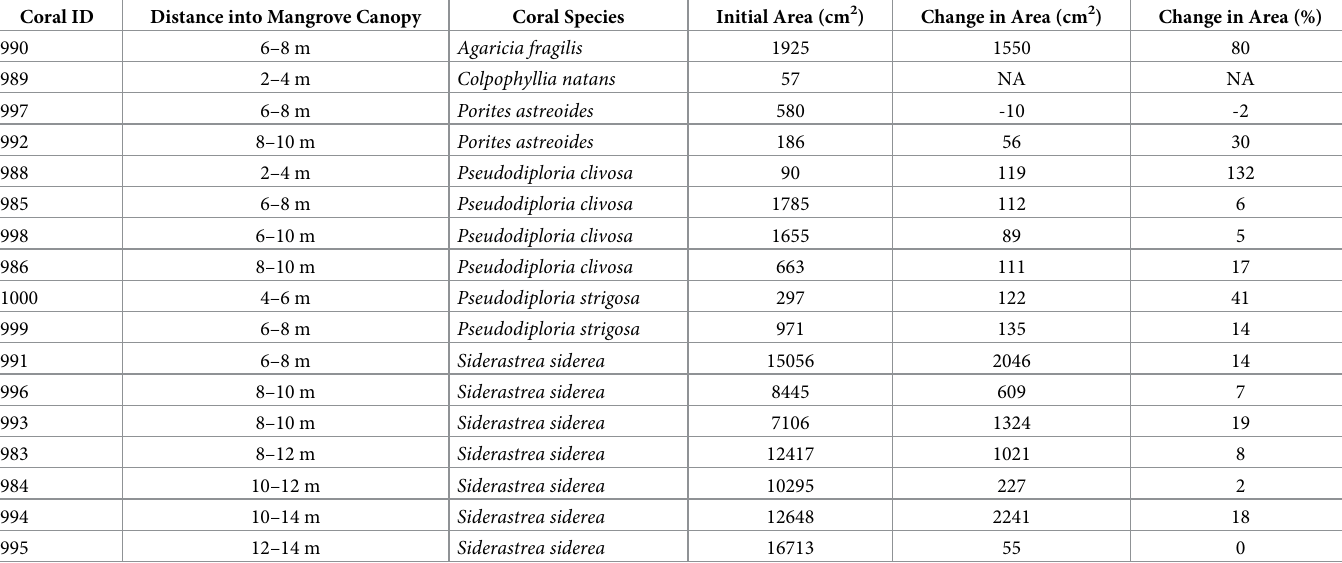
able to regenerate plates after breakage (Fig 2). Porites astreoides colonies expanded over the monitored period but growth was difficult to calculate as the colony was dynamic with con- stant turnover of live corals bleaching or breaking and new recruits growing on the dead coral structure. The colony of Agaricia fragilis we monitored increased 80% in area and grew in a mixture of vertical and horizontal plates. Although individual plates showed signs of breaking over this period, overall, the colony grew. Recruits expanded to mangrove roots, but most of the colony grew on the coral rubble between the mangrove roots with the base largely covered in pink crustose coralline algae (CCA). The majority of the monitored coral colonies were Siderastrea siderea because they form the largest colonies within the mangrove with an average surface area of 1.3 m. The S . siderea colonies were most common 6 m or more from the man- grove fringe and increased 7–19%, although the largest colony at 16713 cm 2 showed no change in area over the 14 months. All S . siderea colonies were healthy but some bleaching was observed in corals where mangrove roots rotted and broke off and landed on the coral as well as in areas where colonies of the zoanthid Zoanthus pulchellus overgrew colonies. Mangrove vs. reef habitat comparisons. Habitat type (i.e., mangrove, reef flat, reef slope) had a significant effect on the composition of benthic cover (P = 0.005). The benthic cover groups contributing to the greatest dissimilarity between habitat types were coral rubble, sea- grass, and mangrove root, with the mangrove habitat having the greatest amount of coral rub- ble (Fig 3A). Live coral made up the greatest mean percent cover of all benthic categories across habitat types (43.67 ± 0.05 mangrove, 42.42 ± 0.06 reef flat, 48.35 ± 0.07 reef slope, mean percent cover ± SE). Although there was no difference in percent cover of live coral between habitat types (P = 0.771), we found significant differences in species richness (P = 0.036) and Shannon diversity index (P < 0.001). Tukey post-hoc tests showed signifi- cantly greater coral diversity within the mangrove canopy and on the reef slope than on the reef flat, but no difference in coral diversity between mangrove canopy and reef slope (S3 Table). Quantity of live coral colonies varied significantly with coral species (P < 0.001) and